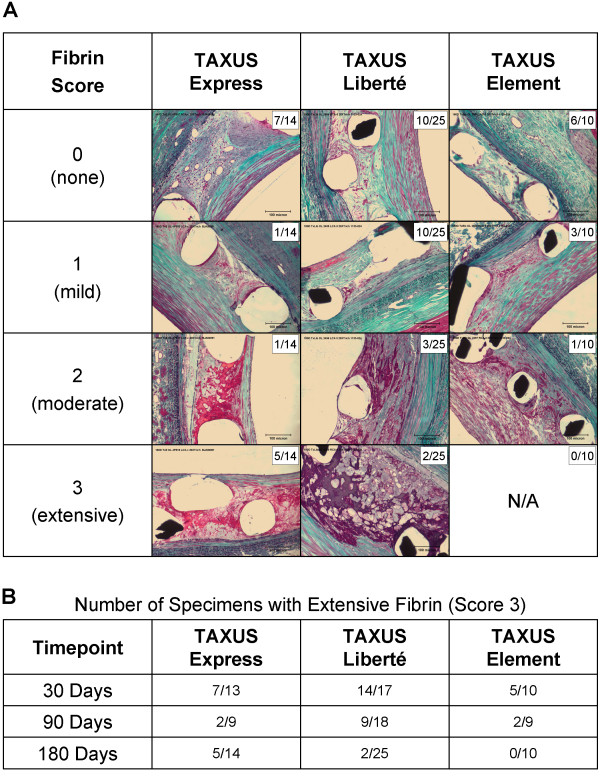
Fibrin deposition around stent struts following TAXUS stent implantation in porcine coronary arteries. Swine coronary arteries were implanted with overlapping bare metal or TAXUS Express, TAXUS Liberté, or TAXUS Element paclitaxel-eluting stents and examined at 30, 90, and 180 days using light microscopy. Peristrut fibrin deposition was evaluated by study pathologists and scored on a 0-3 scale where 0 = no visible fibrin, 1 = mild fibrin present, 2 = moderate fibrin present, 3 = extensive fibrin present. Trichrome stained sections, 200× plate magnification. See Seifert et al., 2007 for more detailed methods [29]. (A) Example specimens at 180 days showing peristrut fibrin deposition histology. Number of specimens in each category is shown as n/N. (B) Number of specimens with extensive fibrin deposition (score 3) at each timepoint. There were no significant differences among control bare metal stents in any of the studies.